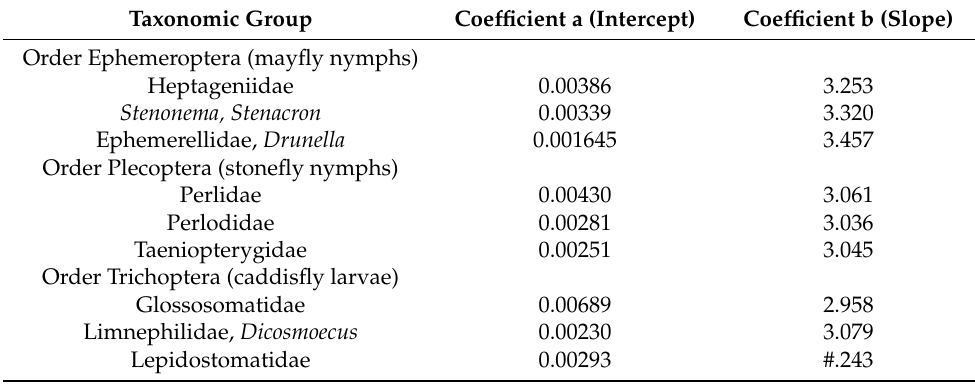
Table 5. Regression coefficients for representative Ephemeroptera, Plecoptera, Trichoptera (EPT), based on stream collections made in Michigan, Pennsylvania, Idaho, Oregon, and Maryland, USA, from the unpublished data of Cummins. Coefficients a and b are based on regressions for each group. Sample sizes ranged from 39 to 100 individual aquatic insects that included a range of sizes. Mean coefficients were calculated from the plots of Y (dry mg) on X (total body length; a = intercept of Y on X and b = slope of Y on X. To convert any numerical EPT sample data to its dry biomass equivalent, multiply each taxonomic entry by thee total body length per individual times the number of individuals in the category and sum